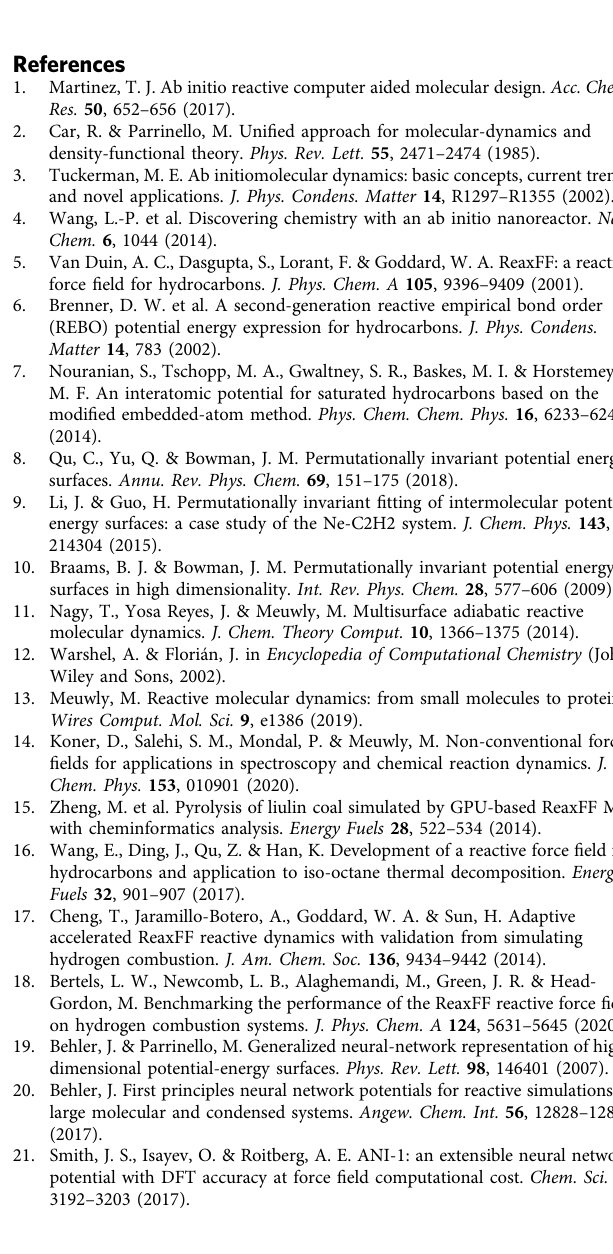
Fig. 6 The neural network model. The neural network model that generates the potential energy surface for